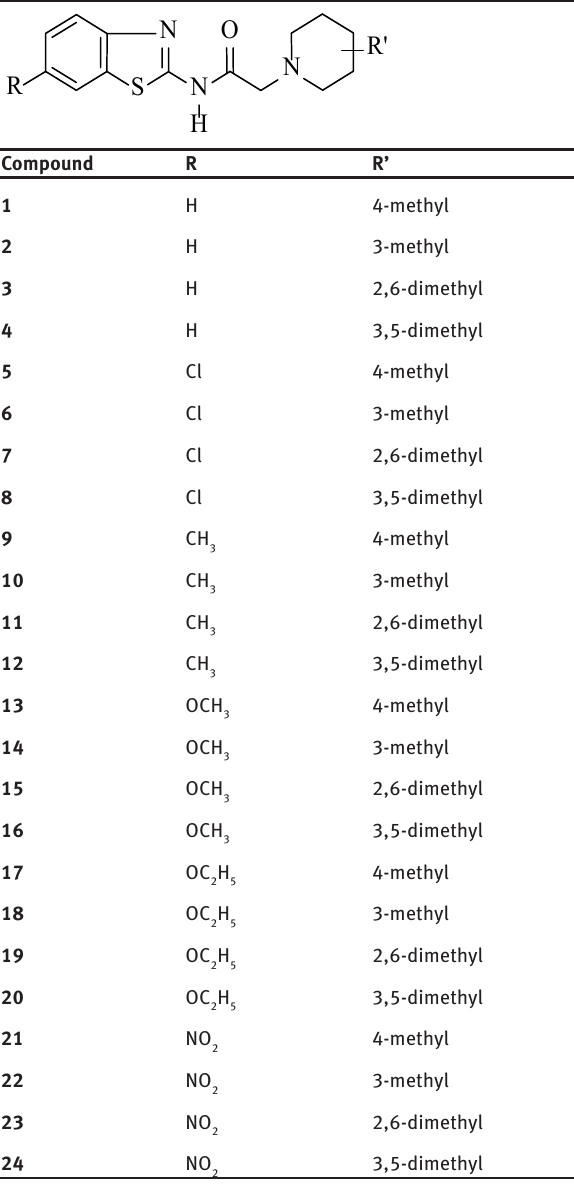
Table 1: Structures of compounds 1-24